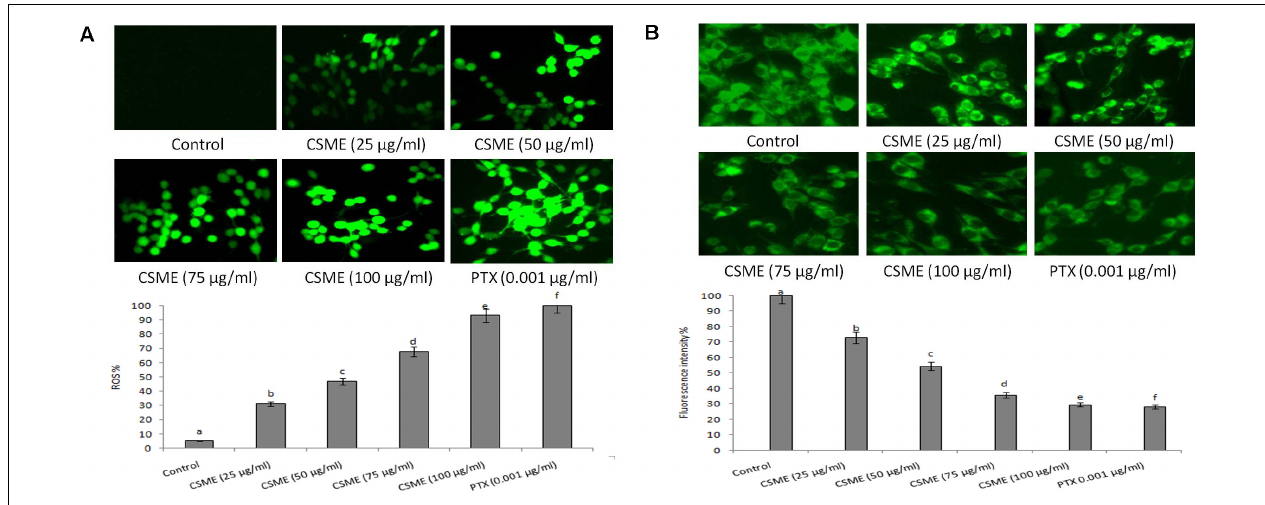
FIGURE 5 | CSME treatment induces ROS and alterations in mitochondrial membrane potential in MDA-MB-231 cells. Photomicrograph shows (A) enhanced fluorescence intensity in MDA-MB-231 cells after treatment with different concentrations of CSME. (B) MDA-MB-231 cells after treatment with different concentrations of CSME displayed diminished green fluorescence. The cells were observed under a green lamp (Floid cell imaging system, Invitrogen). Bar diagram represents fluorescence intensity observed under excitation and emission at 485 and 530 nm, respectively, using a multimode reader (Tecan, Austria). Values are expressed as mean ± SD of six experiments in each group. Values not sharing a common marking (a, b, c, d, e, and f) differ significantly at P < 0.05